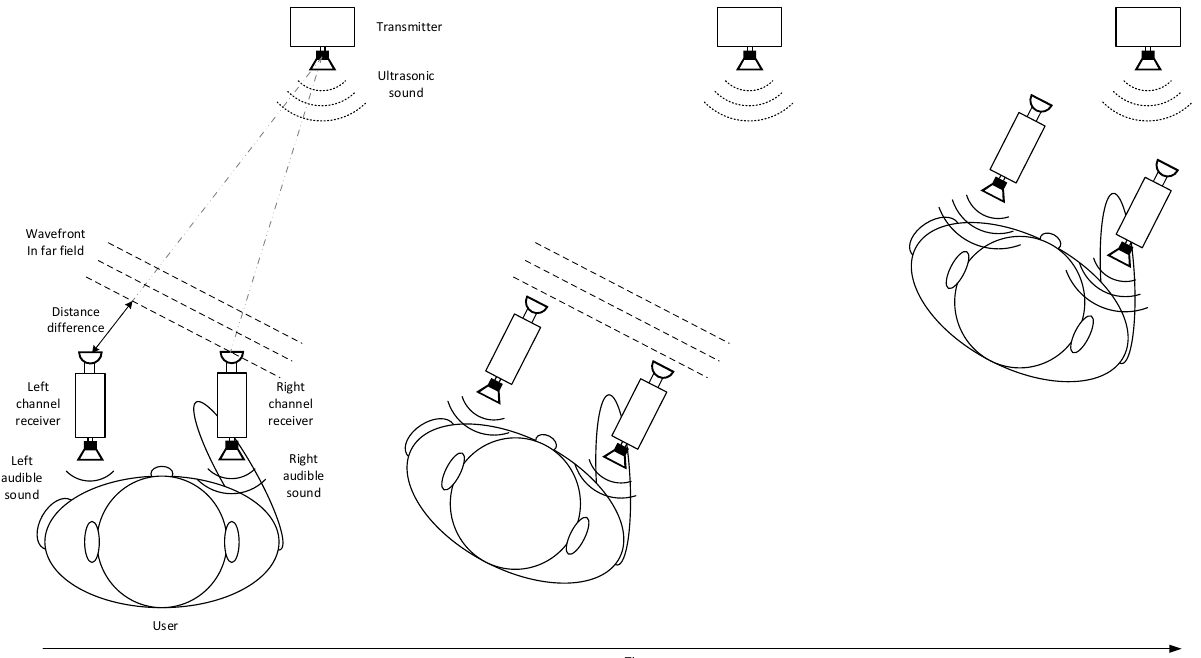
Figure 8. Working example of dual channel device for user to locate the